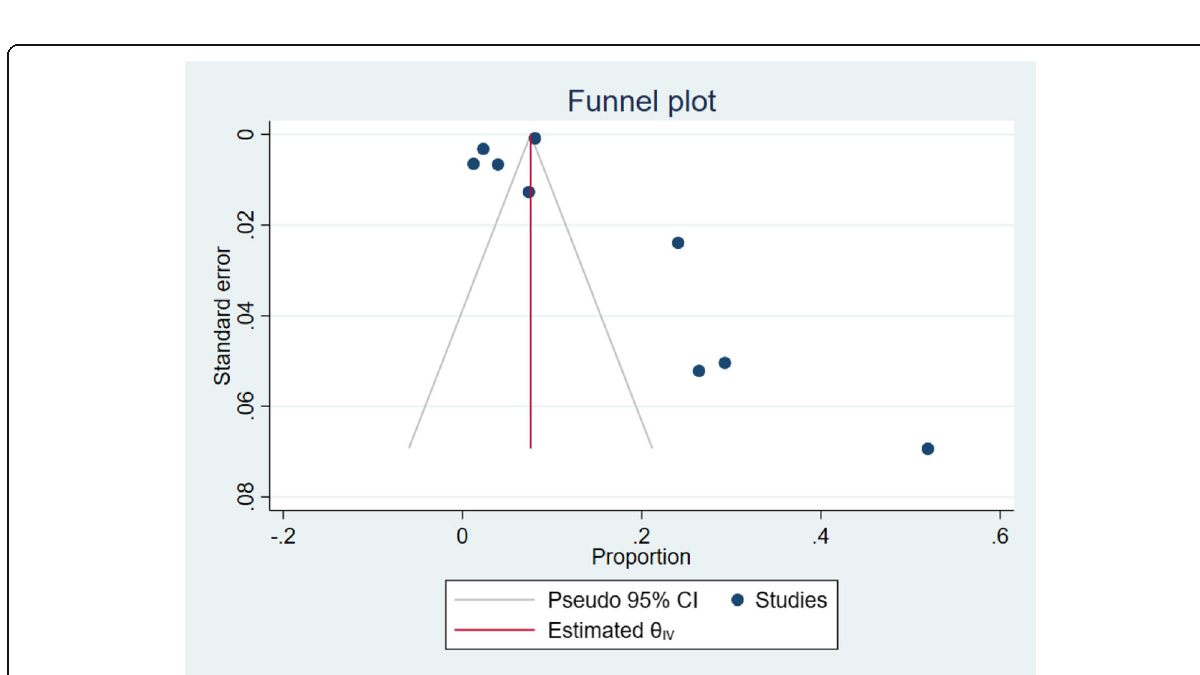
Fig. 3 A funnel plot showing the distribution of eligible